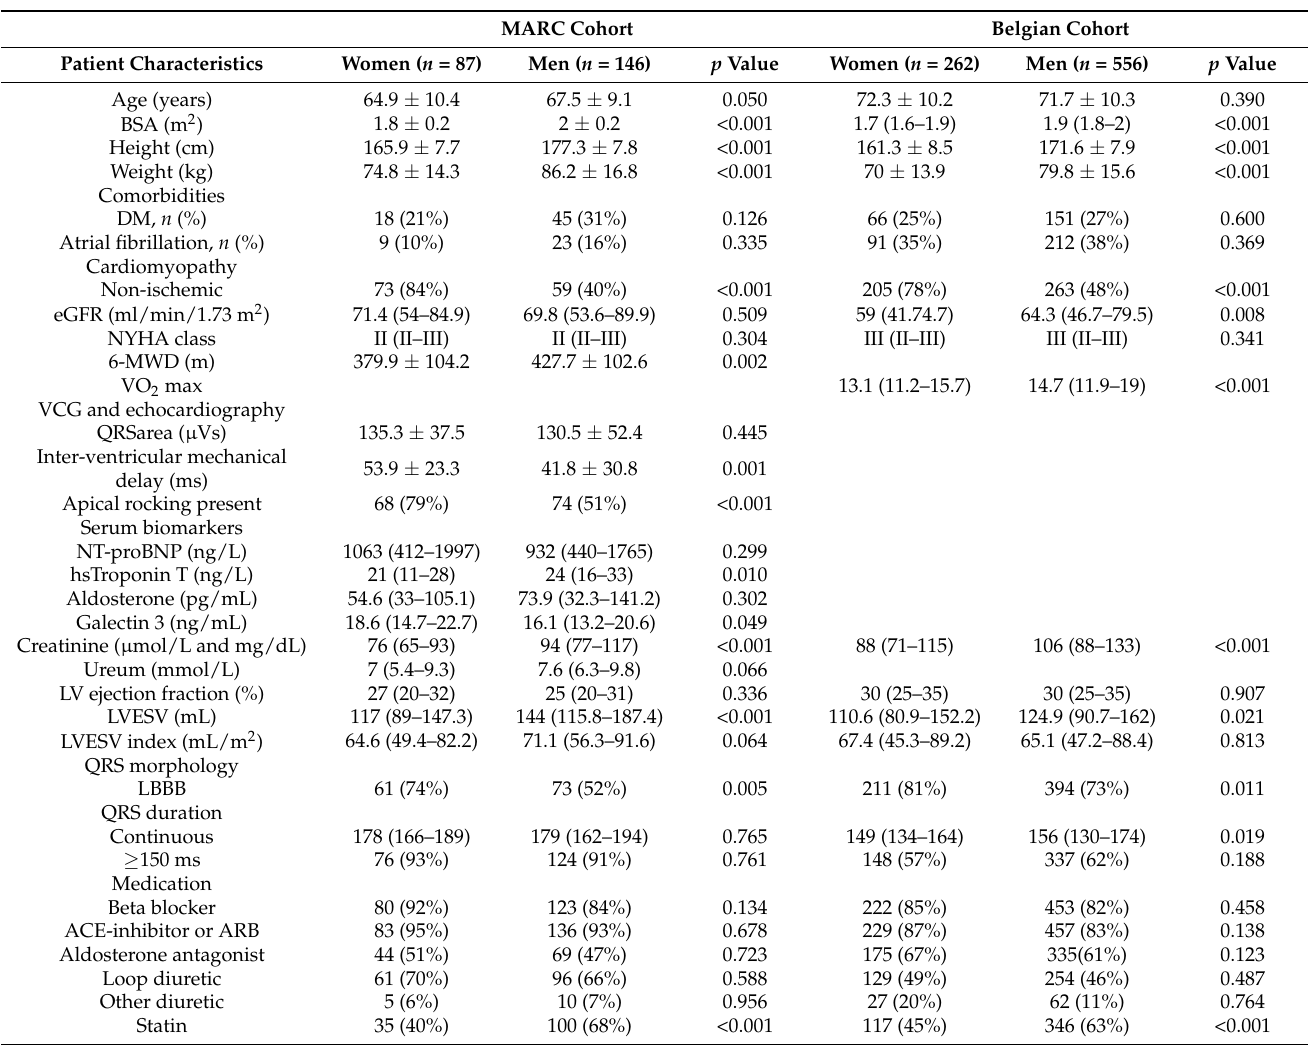
Table 1. Baseline characteristics based on